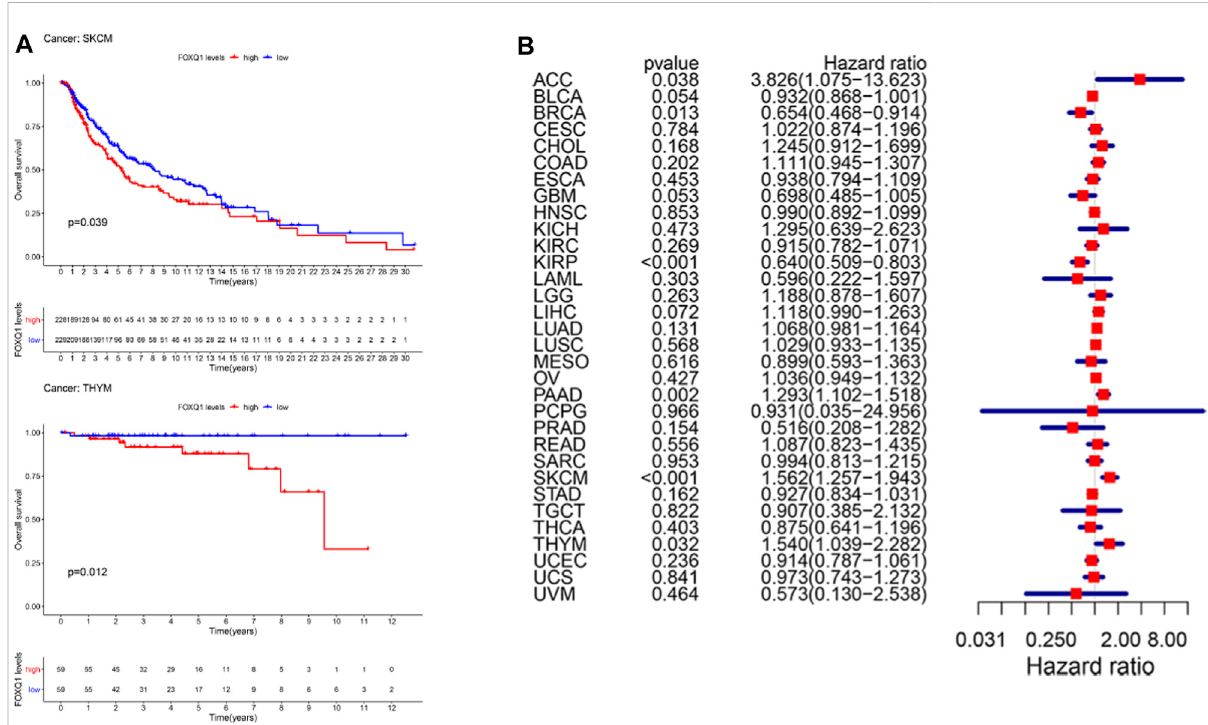
FIGURE 2 Correlation of forkhead box Q1 (FOXQ1) expression with overall survival in different cancer types. (A) Kaplan – Meier curve based FOXQ1 expression in cancer. Red color represents high expression and blue color represents low expression. (B) forest plot for the overall survival analysis of FOXQ1 in